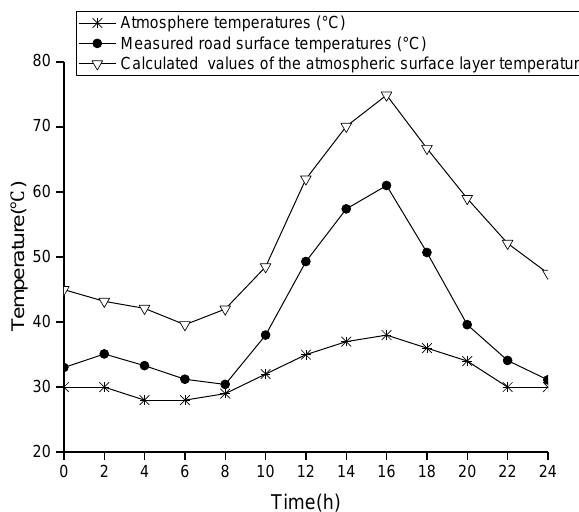
Figure 14. Comparison on atmosphere temperatures, the measured road surface temperatures, and the